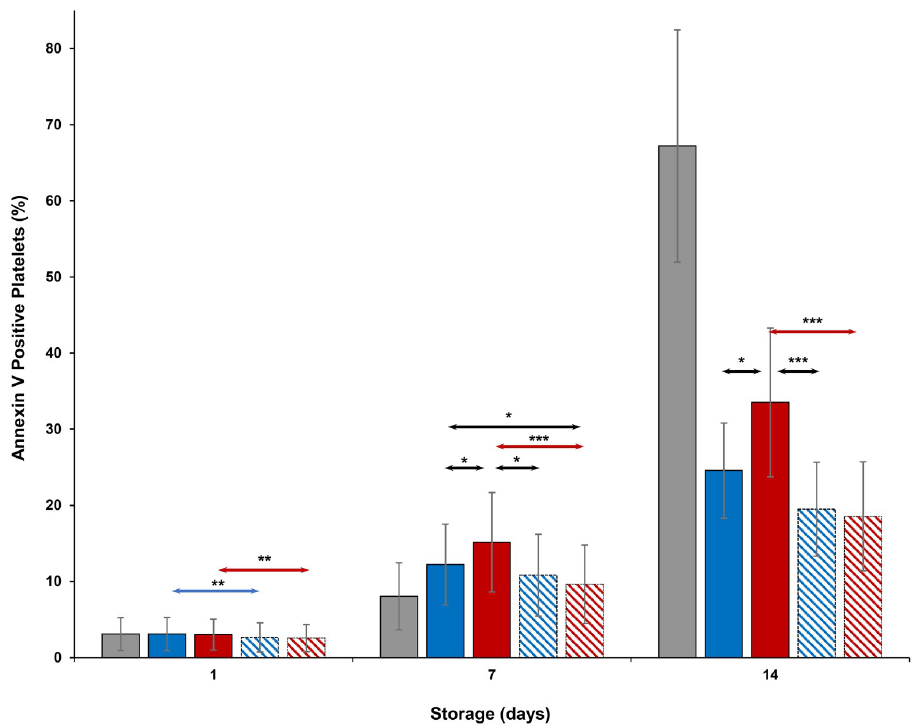
Fig 9. Effects of 14-day storage, temperature and presence of p38MAPK inhibitor on annexin V binding. Grey bar–platelets stored at room temperature; blue solid bar–cold-stored platelets; red solid bar–thermocycled-stored platelets; blue striped bar–cold-stored + VX-702 platelets; red striped bar–thermocycled-stored + VX-702 platelets. Data represents the mean of 15 experiments with one standard deviation. Arrows represent paired statistical differences; � —p < 0.05, ��� —p <